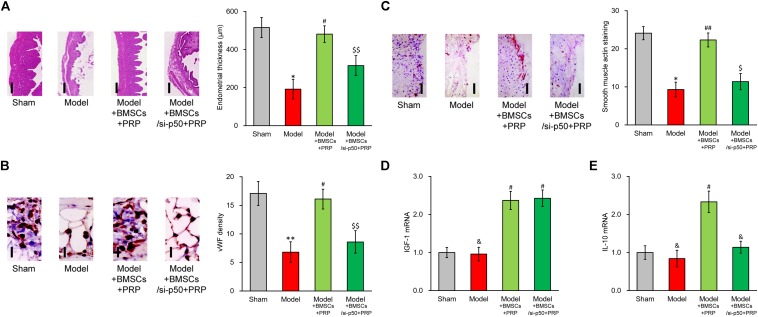
Enhancing effect of PRP therapy on BMSCs transplant in treating injured rat uterus requires p50. Rats were divided into sham, model, model receiving control BMSC transplant and PRP therapy (Model + BMSCs + PRP) and model receiving p50-silenced BMSC transplant and PRP therapy (Model + BMSCs/si-p50 + PRP), with 8 rats per group. 28 days after the treatment, (A) representative histological images (left side, scale bar 100 μm) and bar graph showing endometrial thickness in the regenerative uterine horns, (B) representative histological images (left side, scale bar 20 μm) and bar graph showing neovascularization measured as vWF staining density in the newly regenerated uterine endometrial, (C) representative histological images (left side, scale bar 50 μm) and bar graph showing smooth muscle regeneration measured as smooth muscle actin staining, were assayed in the experimental animals. (D,E) mRNA levels of IGF-1 (D) and IL-10 (E) were examined in regenerated endometrium samples 28 days after the treatment. Values are mean ±SD (n = 8 each group). ∗∗P < 0.01, ∗P < 0.05, &P > 0.05, vs. sham. #P < 0.05, ##P < 0.01, vs. both sham and model. $P < 0.05, $$P < 0.01, vs. both sham and Model + BMSCs + PRP.